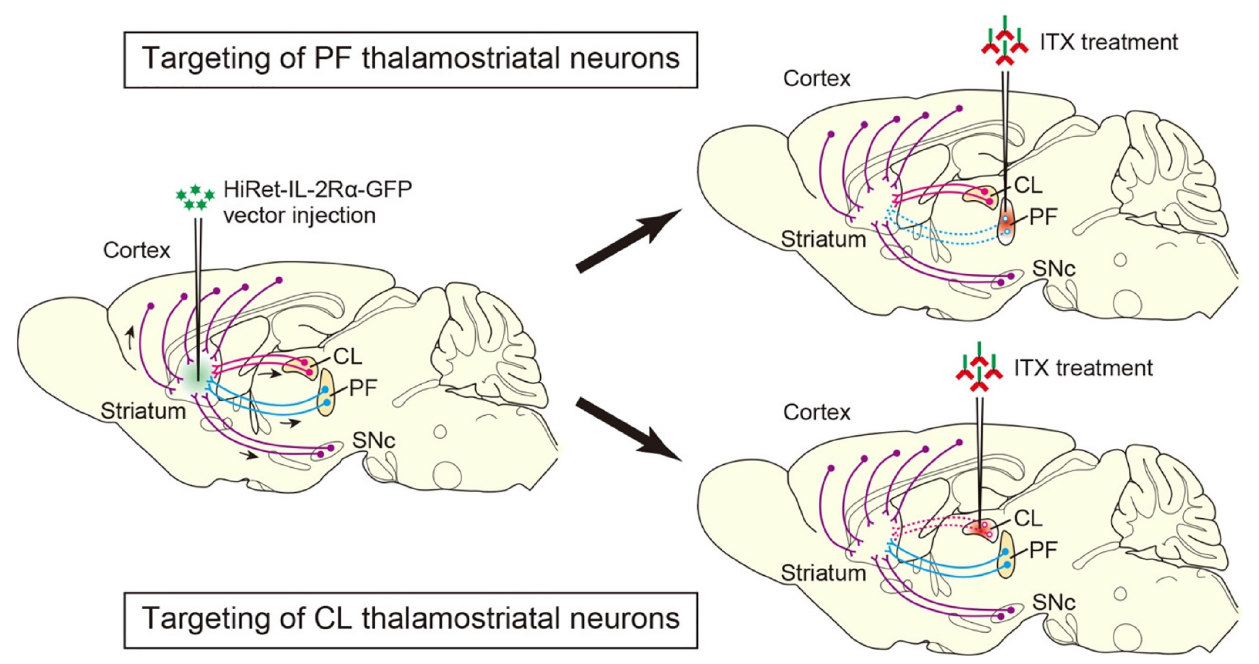
FIGURE 1 | Selective neural pathway targeting of thalamostriatal neurons arising from the PF and CL. The highly efficient retrograde gene transfer (HiRet)-IL-2R α -GFP vector is injected into the dorsal striatum (DS) and transported retrogradely through axons to various brain regions, in which the expression of the IL-2R α -GFP transgene is induced. ITX is then treated into the PF and CL, resulting in the elimination of thalamostriatal neurons expressing the transgene in the PF and CL, respectively. Arrows show retrograde axonal transport of the viral vector. Dotted lines indicate the removal of the corresponding neural pathways. HiRet,